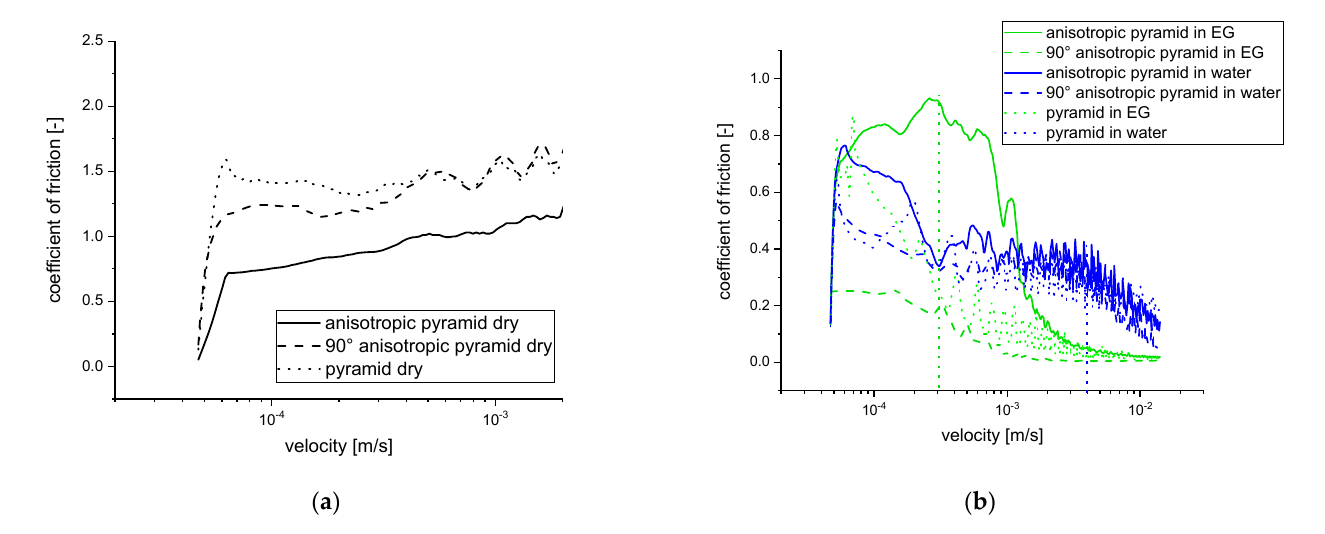
Figure 11. Ninety-degree anisotropy of friction for anisotropic pyramids in comparison to isotropic pyramids: ( a ) dry and ( b ) water and ethylene glycol (EG). Vertical broken lines indicate the transition to mixed lubrication.